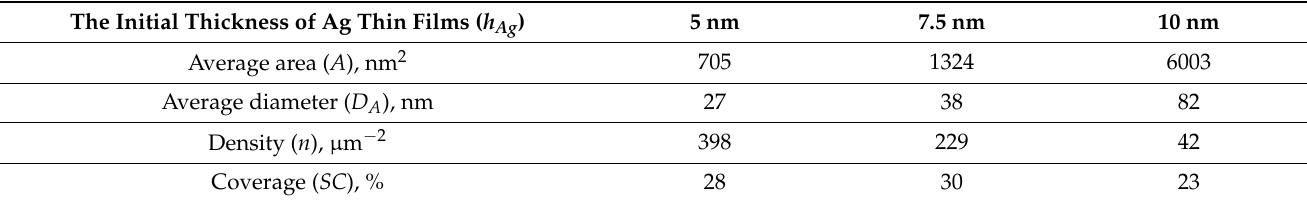
Figure 3. The diameter ( d ) distribution of AgNPs and SEM of AgNP/TiO 2 structures obtained by SSD process ( T a = 400 °C, t a = 60 min) using different h Ag : ( a ) 5 nm; ( b ) 7.5 nm; ( c ) 10 nm, and ( d ) the average NP diameter (< d >) dependence on h Ag . Table 1. The parameters of AgNPs on the surface of TiO 2 . Table 1. The parameters of AgNPs on the surface of TiO 2 .